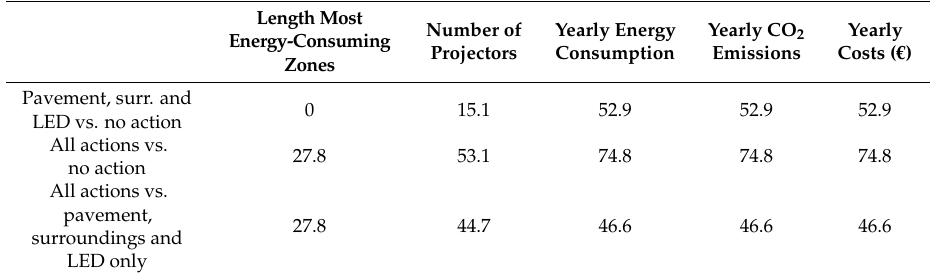
Table 7. Savings achieved with the actions introduced in this work with respect to the previous, where only basic savings actions were considered. All values expressed in